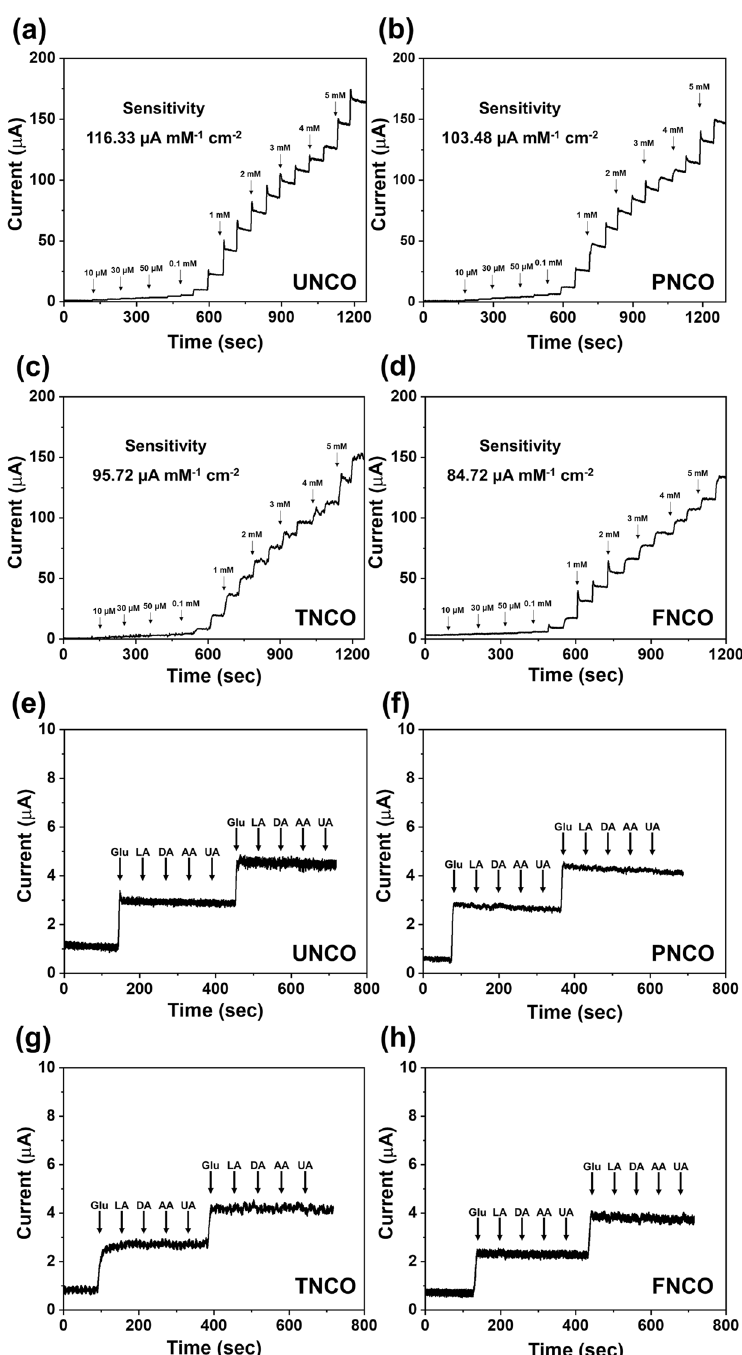
Figure 6. CA responses of ( a ) UNCO, ( b ) PNCO, ( c ) TNCO, and ( d ) FNCO electrodes with the addition of glucose to 0.1 M NaOH solution at 0.50 V. The inset shows the calibration curves for the current response of the NCO nanomaterials; CA responses of ( e ) UNCO, ( f ) PNCO, ( g ) TNCO, and ( h ) FNCO with the stepwise addition of 1 mM glucose and 0.1 mM interfering species (LA, DA, AA, and